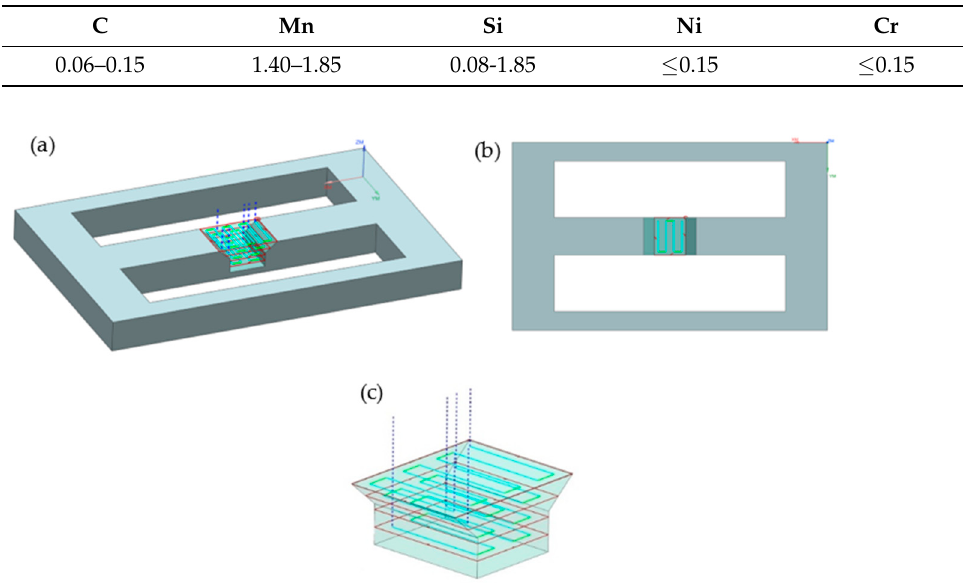
Figure 1. Sketch of the specimen (mm). ( a ) Isometric view; ( b ) Front view; ( c ) Top view; ( d ) Section view. Table 2. Chemical composition of welding wire (wt. %).